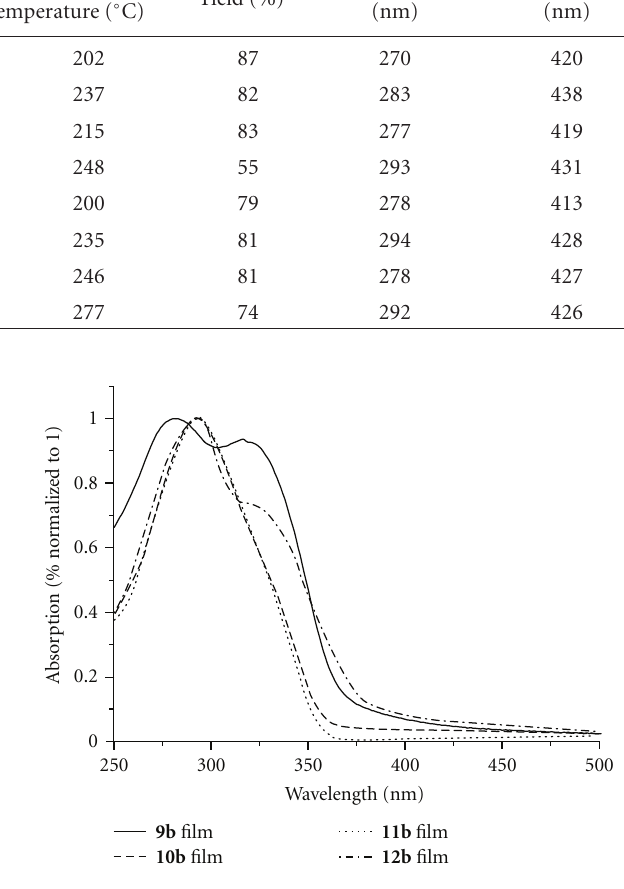
Figure 5: UV spectra of parasubstituted polymer films 9b – 12b on silica glass.